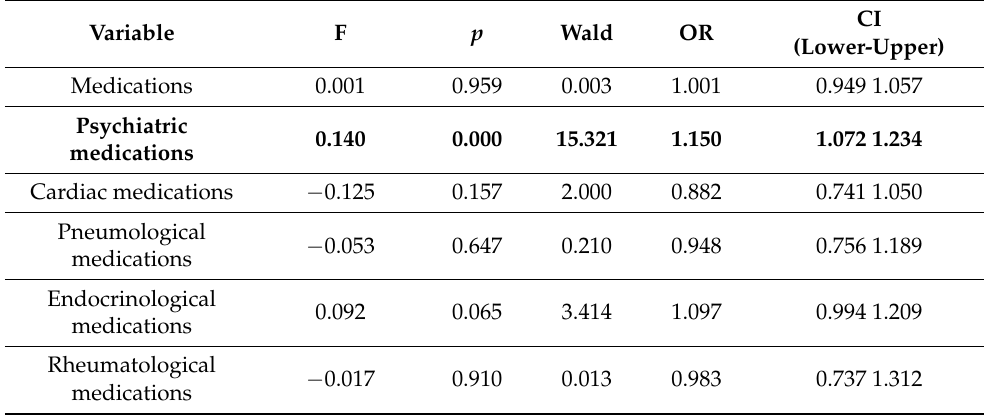
Table 3. Relationship between severity of mixed symptoms and current medications and post- COVID-19 syndrome’s symptoms in